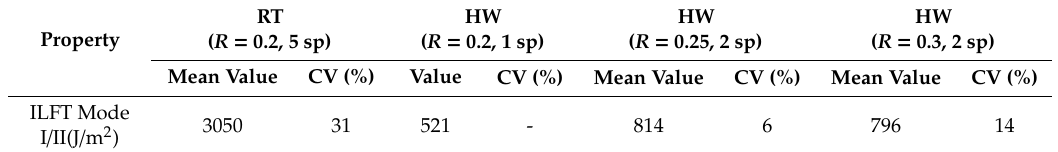
Table 12. E ff ect of hot-wet storage aging on interlaminar fracture toughness in Mode I / Table 12. Effect of hot-wet storage aging on interlaminar fracture toughness in Mode I/II.